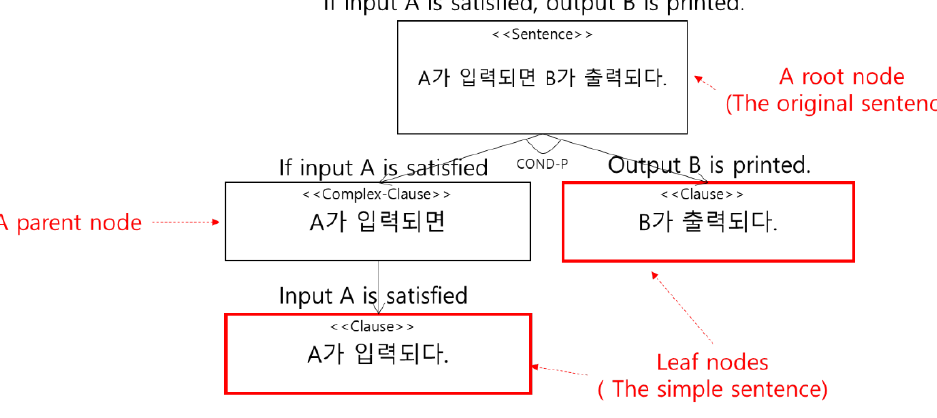
Figure 4. Positive condition relationship.